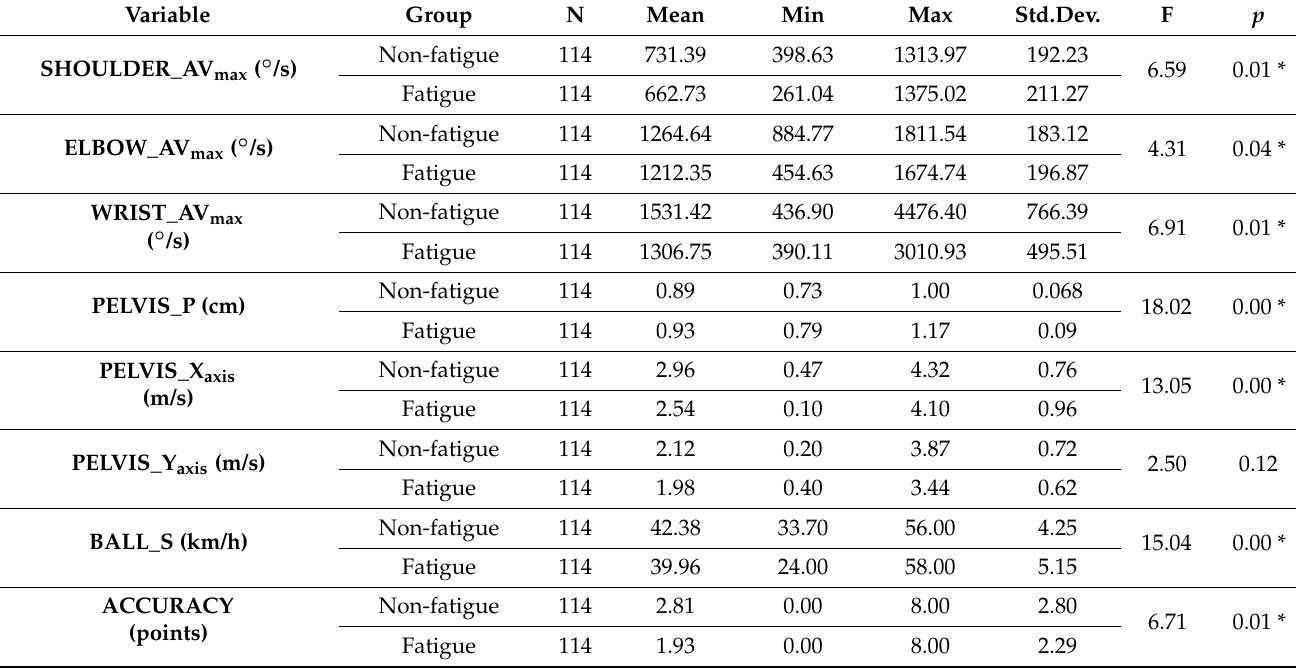
Table 1. Descriptive parameters and result of ANOVA for repeated measures of the fatigue and non-fatigue conditions. Variable